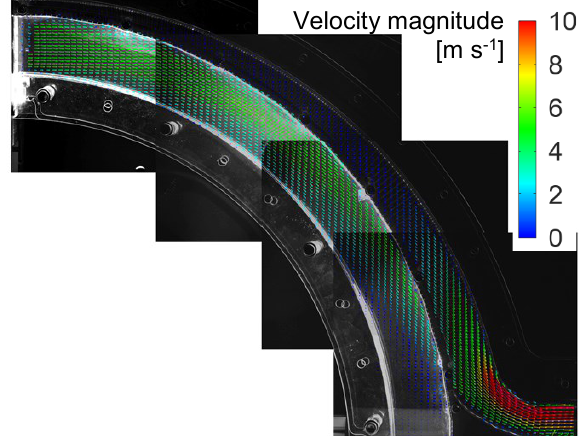
Fig. 2. Velocity vector field coloured by velocity magnitude for mean velocity of 4 m/s .